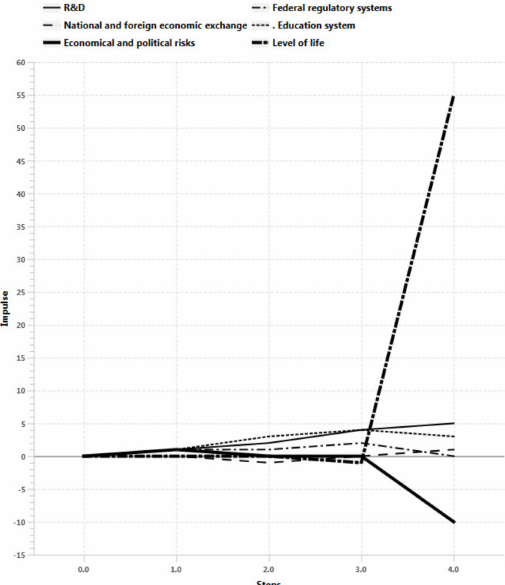
Figure 18. The graph of impulse processes at the selected vertices V6, V7, V10, V12, V16, V20 Scenario "Improving the conditions of higher education and economical and political risks increasing, while federal regulatory systems and R&D reacting" disturbing momentum q6 = + 1, q10 = + 1 and q16 = + 1, q20 =+